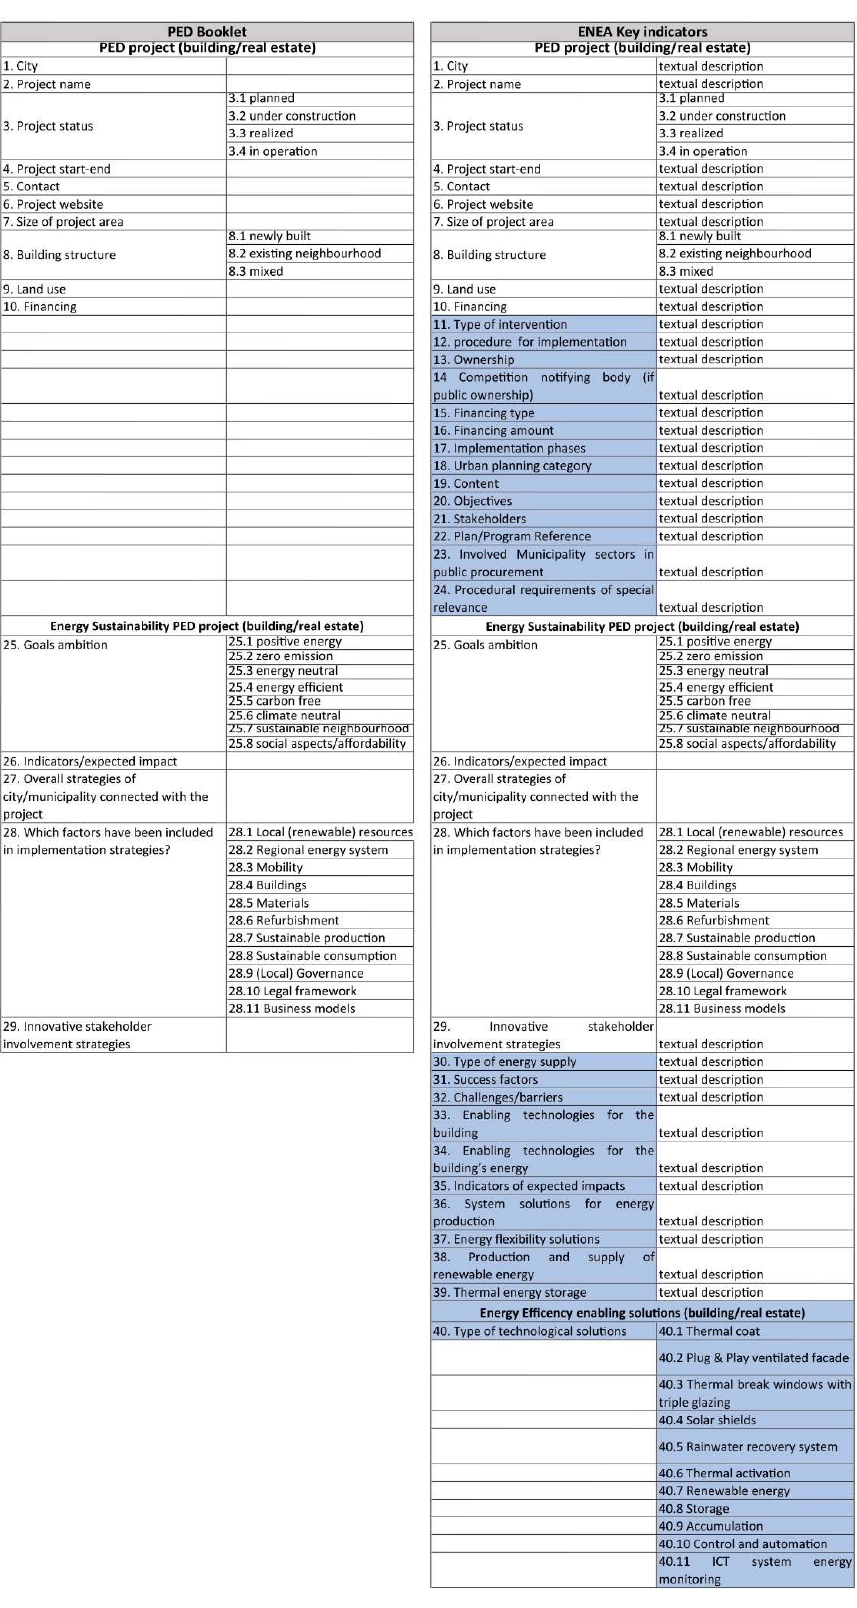
Figure 1. Comparison of indicators and key indicators in the Booklet on PEDs and the ENEA research